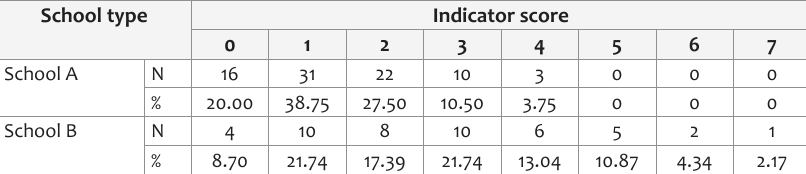
Table 2: Distribution of indicator scores by school type School type